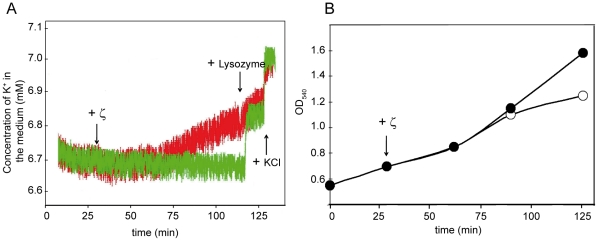
Expression of ζ toxin affects the membrane permeability.(A) lacI-P
hspζ (xylR-P
XylAε) cells were grown in two parallel vessels containing 30 ml MMS7 at 37°C up to ∼5×107 cells ml−1 in the presence of traces of Xyl (0.005%) and the K+ concentration in the medium was recorded. Then, 1 mM IPTG was added to one of the vessels and the monitoring of K+ concentrations in the cell suspensions was followed for 100 min (red curve). For control of the intracellular K+ content lysozyme (30 µg ml−1) was added as well as calibration of the electrodes by 6 µmol KCl additions was performed at indicated time frames (green curve). (B) lacI-P
hspζ (xylR-P
XylAε) cells were grown in two parallel vessels in MMS7 at 37°C up to OD560 in the presence of traces of Xyl (0.005%). Then, 1 mM IPTG was added to one of the vessels (empty circles) and OD560 recorded. In A and B, the arrows point at the time of addition of the indicated compound.